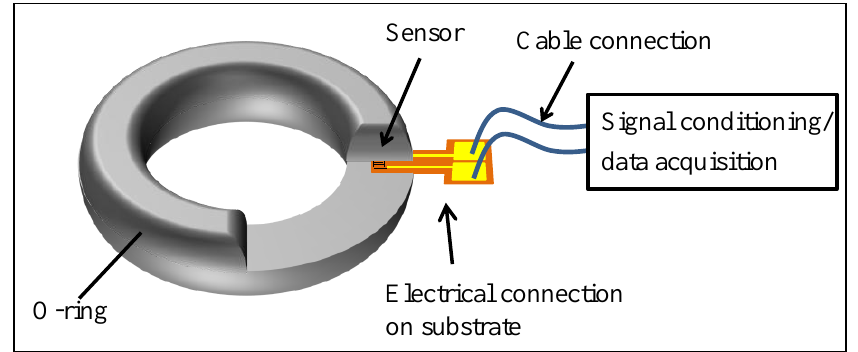
Figure 2. Illustration of an embedded strain gauge in a silicone